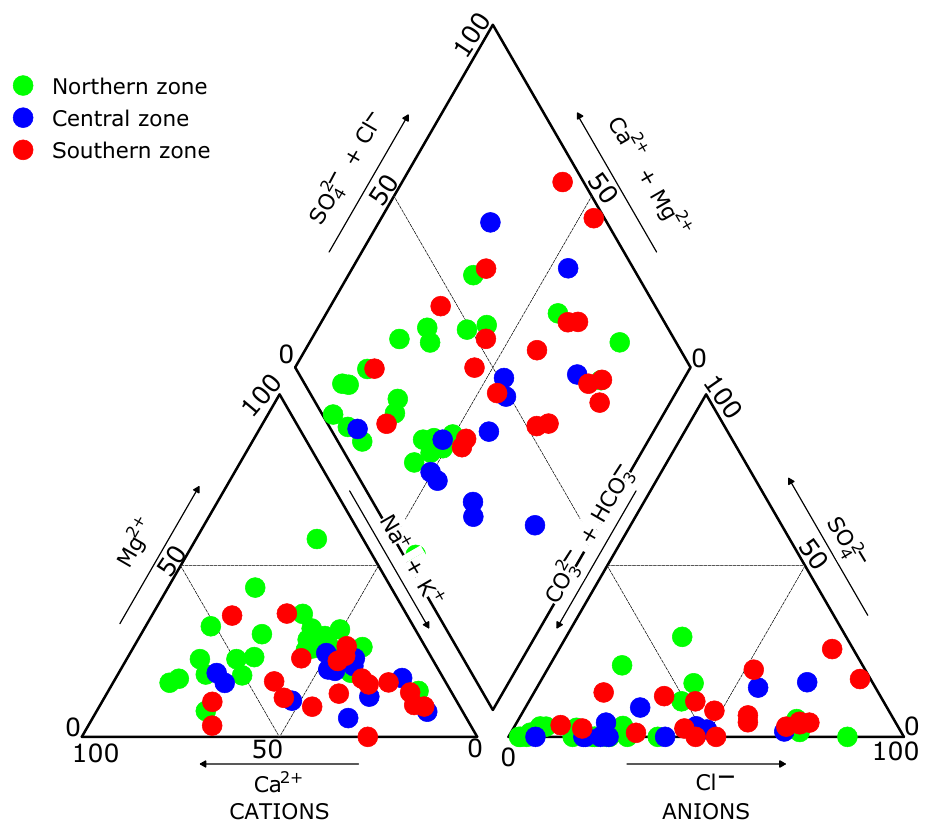
Figure 10. Piper diagram presenting the dominant ion species in the